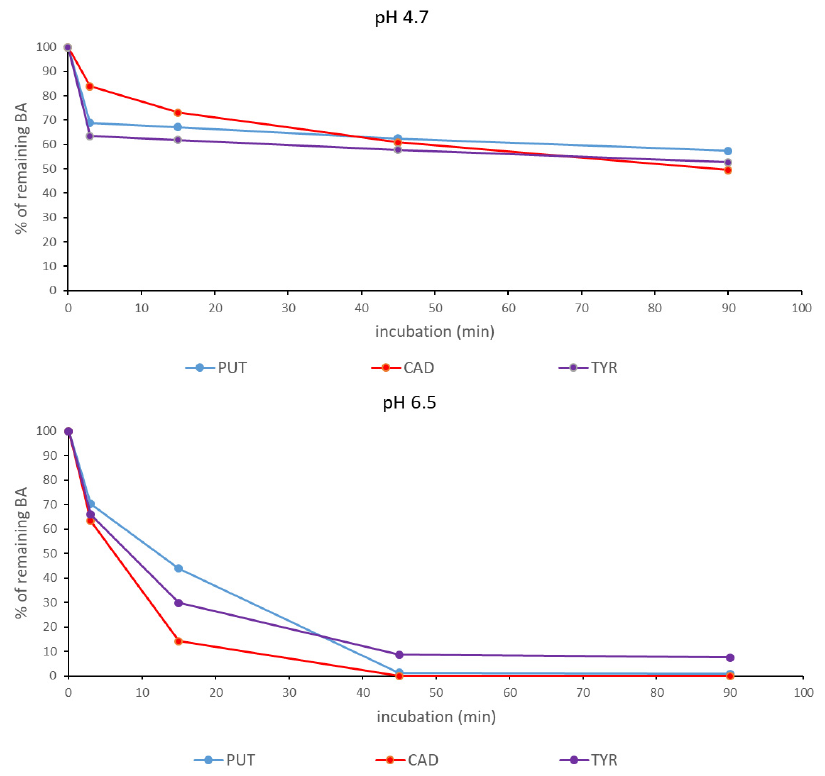
Figure 4. Degradation of biogenic amines (PUT—putrescine; CAD—cadaverine; TYR—tyramine) in the suspension of sourdough by diamine oxidase from fenugreek sprouts at pH 4.7 and pH 6.5. To test the efficacy in a real dough matrix, PUT, CAD, and TYR were incorporated in the dough at 25 mg/kg each along with lyophilized fenugreek sprouts (5.5 mg sprouts/g dough). The content of BA was determined within 15 min of kneading the dough and